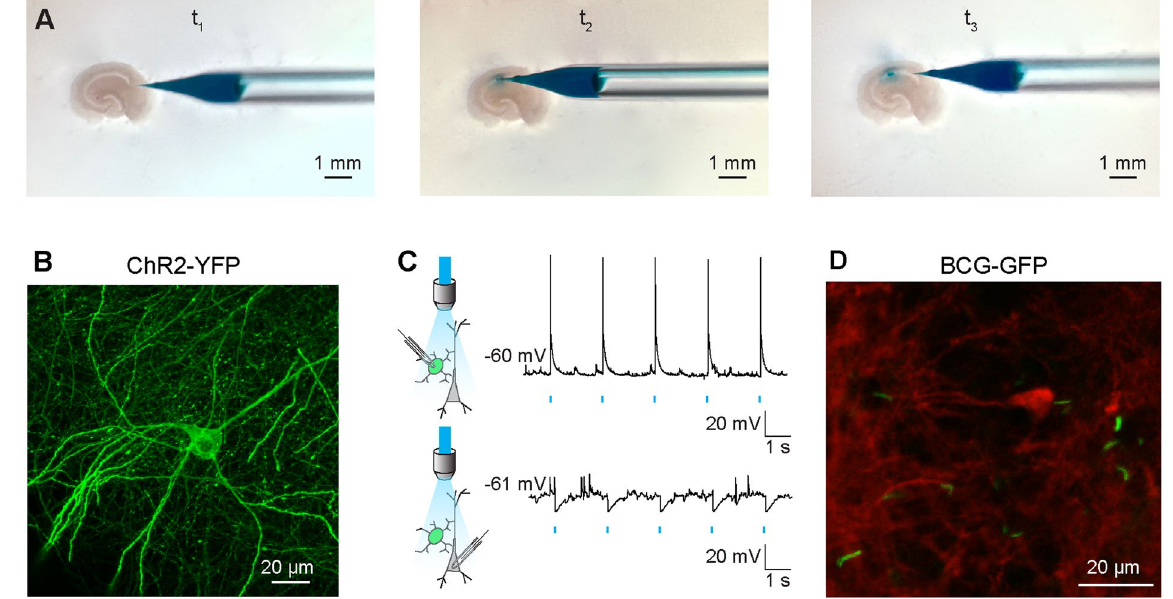
Figure 6. Openspritzer enables microinjections of infectious agents including viral delivery of opsins for optogenetics. ( A ) Openspritzer was used to perform spatially localised microinjections of infectious agents in mouse organotypic brain slices from GAD2-cre transgenic mice. At t 1 a micropipette containing AAV1 carrying floxed Channelrhodopsin2 as well as fast green (0.1%) for visualisation can be observed near the brain slice. At t 2 the glass micropipette pierced the slice surface in the CA1 area. A train of puffs triggered by a foot pedal connected to Openspritzer injected small, controlled, volumes into the brain parenchyma. At t 3 the micropipette was removed. Fast green enabled the small (200 μ m diameter) inoculated area to be visualised. ( B ) Confocal image of a Channelrhodopsin2 expressing interneuron transfected as in A. ( C ) Top, whole-cell patch clamp recording from a neuron expressing ChR2. 488 nm light application using a high-powered LED results